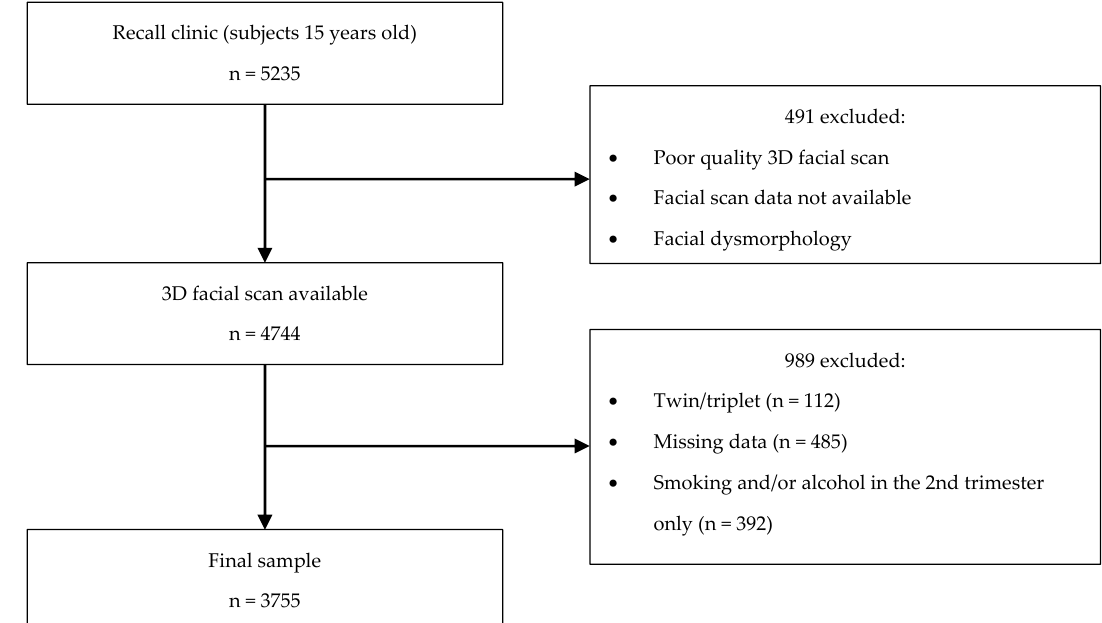
Figure 2. A flow chart of participant inclusion.